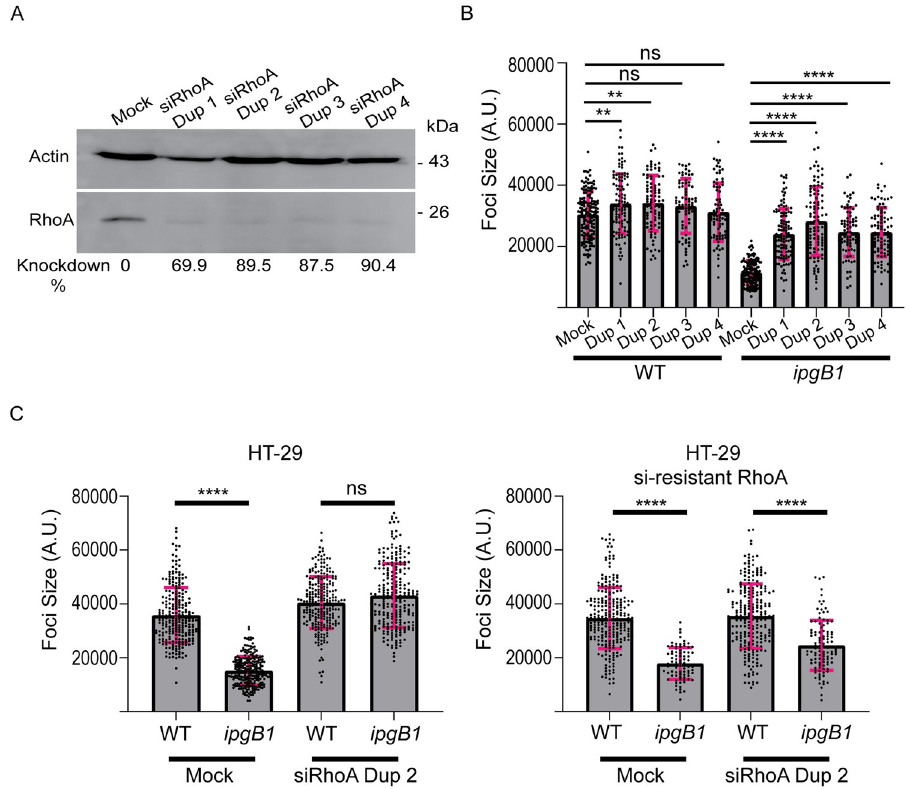
Fig 4. RhoA depletion restores ipgB1 cell-to-cell spread. (A) Western blot showing knockdown efficiency of four siRNA duplexes targeting RhoA. RhoA (bottom panel) was normalized to loading control (actin, top panel) and knockdown efficiency was calculated relative to mock treated cells. (B) Quantification of wild type or ipgB1 foci size at 16 hr postinfection in mock treated cells or cells transfected with four RhoA-targeting siRNA duplexes. (C) Quantification of wild type or ipgB1 foci size at 16 hr postinfection in HT-29 cells (left graph, HT-29) or HT-29 cells stably expressing siRNA duplex 2-resistant mCherry RhoA (right graph, HT-29 si-resistant RhoA) under mock-treated conditions or upon knockdown of RhoA with siRNA duplex 2. For (B and C), at least three independent biological replicates were performed, each containing at least 50 foci. Each point represents one focus and the grey bars represent the mean foci size. Error bars represent the standard deviations; one-way ANOVA was performed with Dunnett’s multiple comparisons test; ns, not significant; �� , p < 0.005; ���� , p < 0.0001.